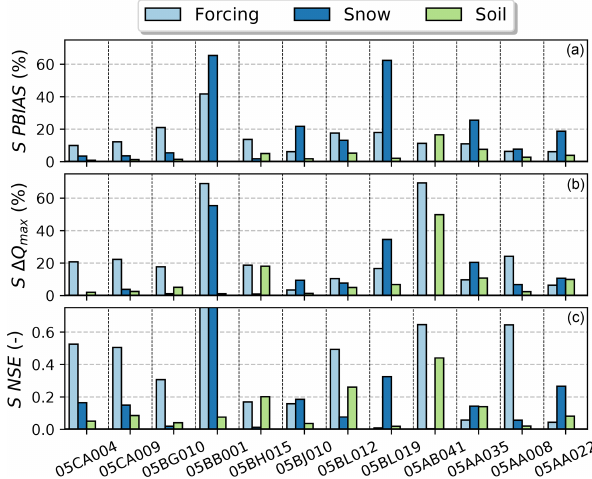
Figure 10. Sensitivity of the error metrics to the three sources of uncertainty considered in this study. The computation of the sensi- tivity metrics is described in Appendix B. The atmospheric forcings at 10 and 1km were considered to obtain the sensitivity to the reso- lution of the atmospheric forcing. Note that the maximal sensitivity for station 05BB001 for NSE is not displayed on the bottom